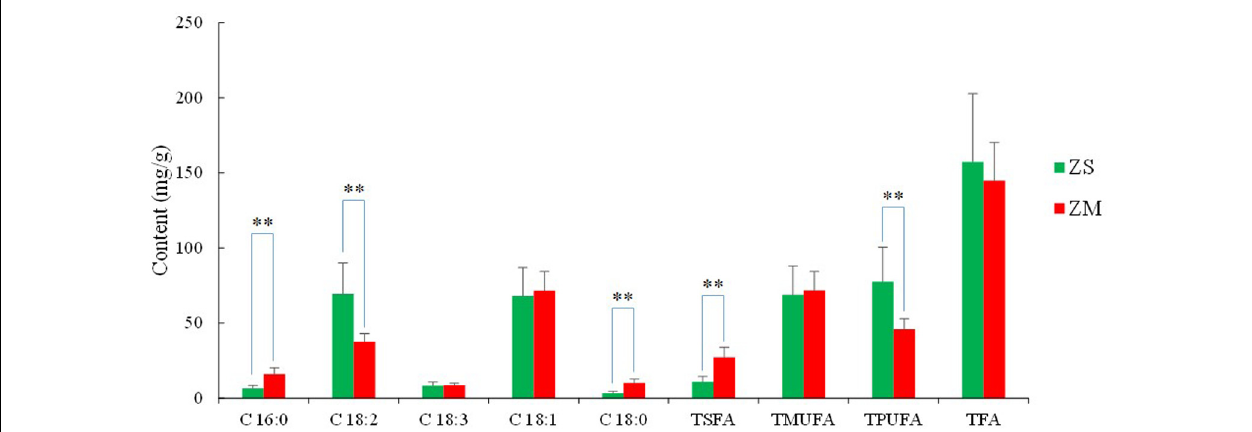
FIGURE 6 | Contents of fatty acids (mg/g) in the seeds of Z. jujuba var. spinosa (ZS) and Z. mauritiana (ZM). Palmitic acid (C 16:0), linoleic acid (C 18:2), linolenic acid (C 18:3), oleinic acid (C 18:1), stearic acid (C 18:0); TSFA, TMUFA, TPUFA, and TTFA refer to the total content of SFA, MUFA, PUFA, and fatty acids, respectively. ∗ P < 0.05, ∗∗ P < 0.01.